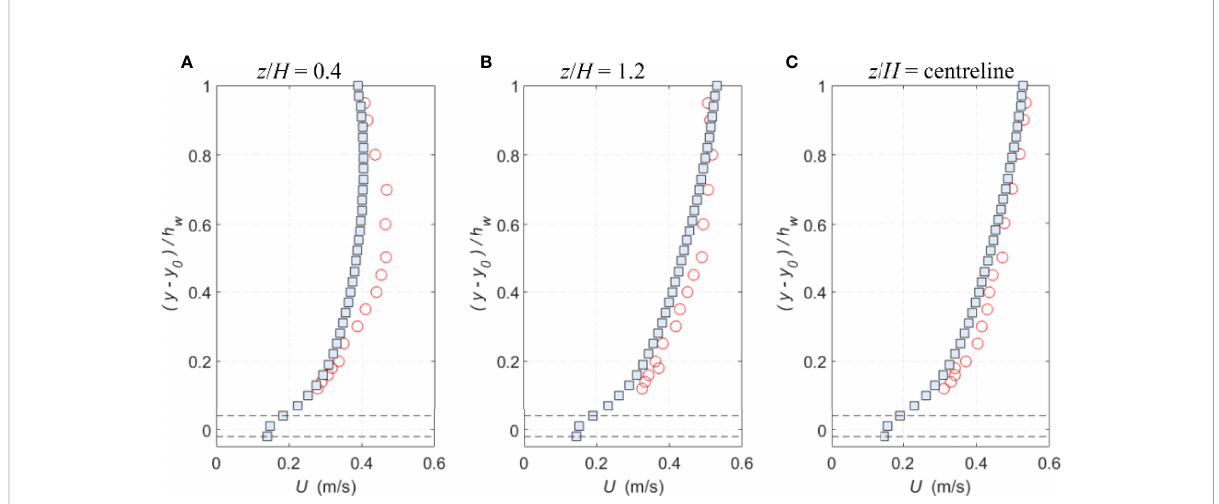
FIGURE 13 (A – C) Comparisons of the lateral pro fi les of time-averaged streamwise velocity between experimental and SPH results for deep fl ow condition 4 (circles: exp data; squares: SPH; and dash lines: roughness top and bottom).